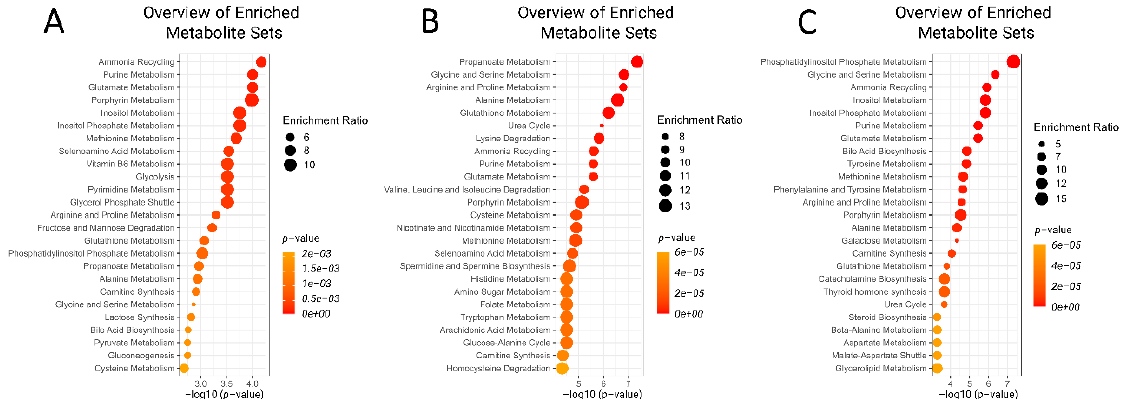
Figure 7. Summary plots for quantitative enrichment analysis at ( A ) −8 weeks and ( B ) −4 weeks prior to parturition and ( C ) week of the diagnosis of retained placenta.